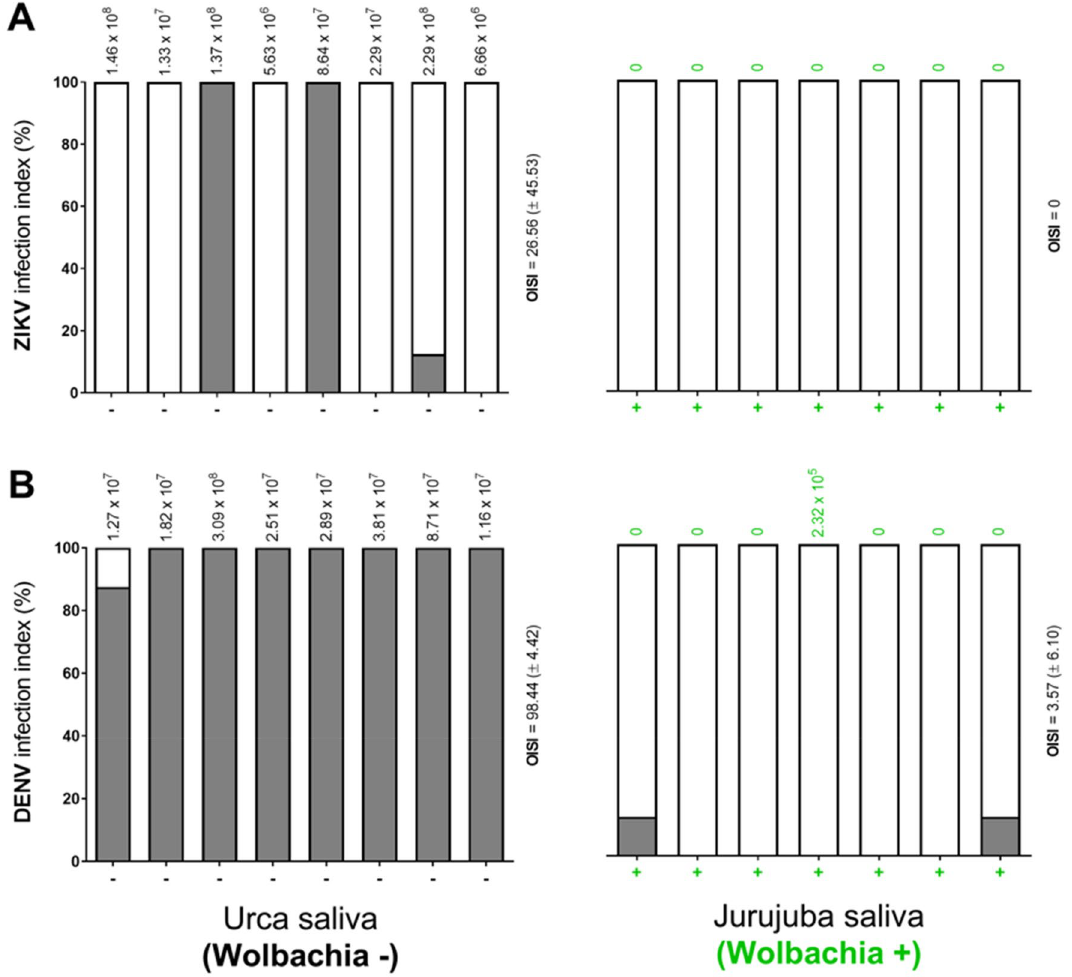
Figure 6. Wolbachia -harboring field samples impair saliva transmission of ZIKV and DENV. ZIKV and DENV transmission by the saliva is affected by the presence of Wolbachia in Jurujuba. Saliva harvested from Wolbachia − Urca (grey) or Wolbachia + Jurujuba samples (green), orally-challenged with ZIKV ( A ) or DENV ( B ), were intrathoracically injected into groups of naïve Urca individuals (n = 8) and consequent infection was determined at 5 dpi, for ZIKV, or at 7 dpi, for DENV. Groups are represented by stacked columns of infected (filled in grey) or non-infected individuals (clear), percent transformed. Viral titers of head/thorax extracts, of corresponding saliva samples, are shown at the top of each column. OISI, the overall saliva intrathoracic infection indexes (± SD) are represented at the right of each graph. Graphs were created and customized with GraphPad Prism 8 (https:// www. graph pad.